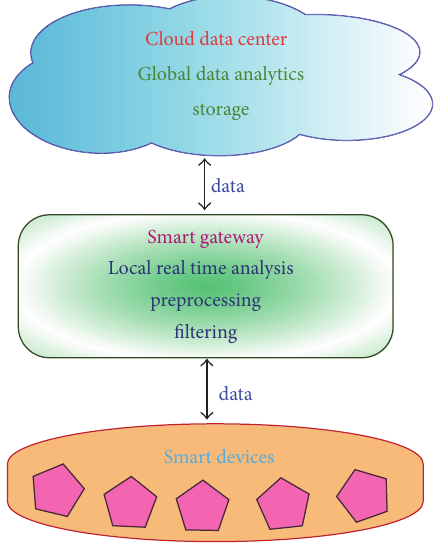
Figure 7: Smart gateway for